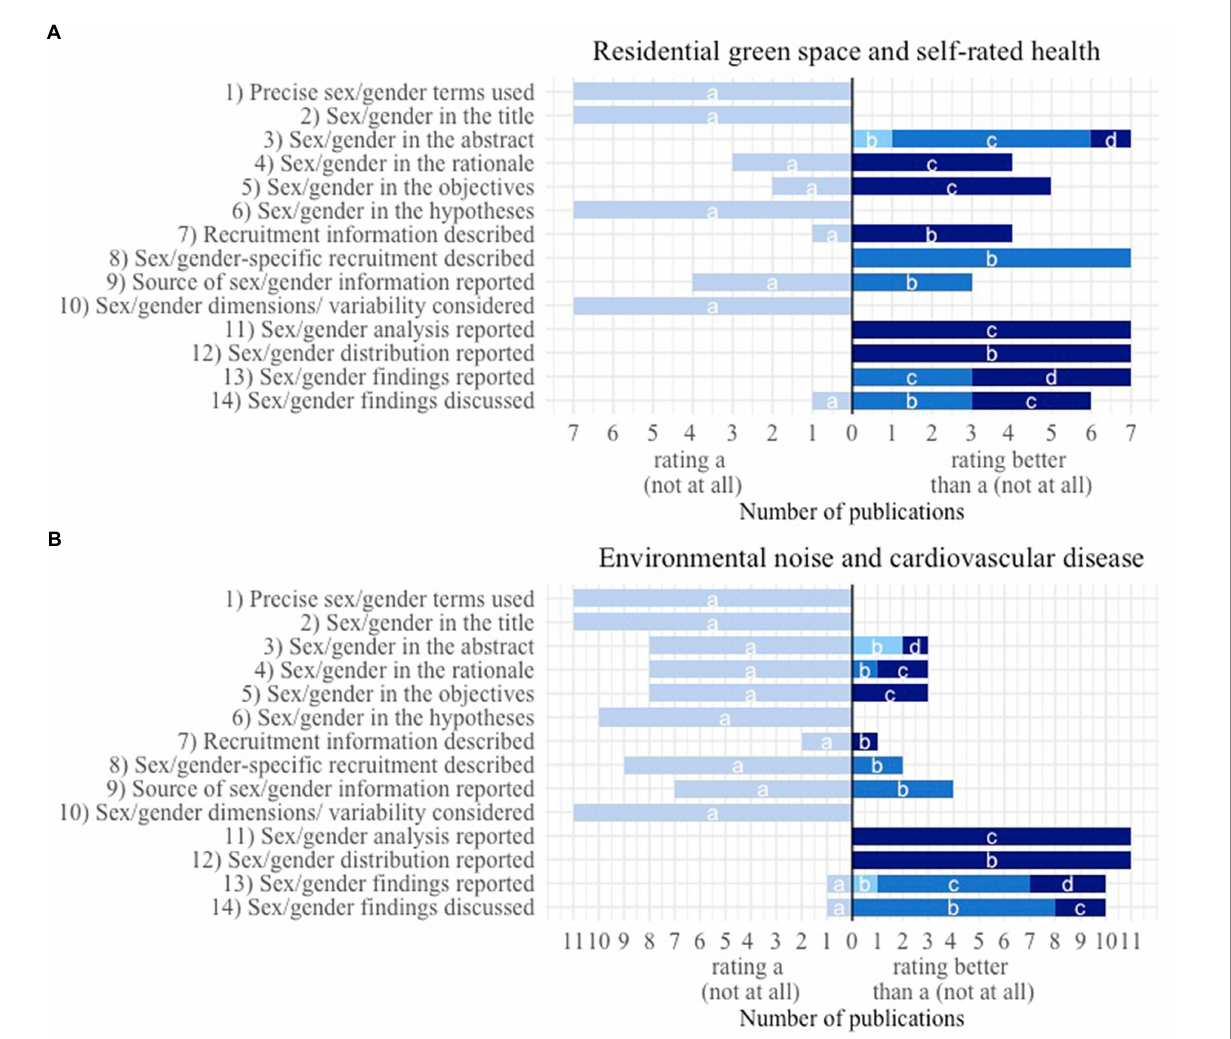
FIGURE 2 Number of publications with a specific rating of the 14 criteria to assess sex/gender consideration. Fulfillment of the evaluation criterion: a – not at all; b, c or d – to a certain extent depending on the specific criterion (for a detailed explanation see results section). (A) Publications identified by the systematic review of Bolte et al. (18) assessing sex/gender in the association between residential green space and self-rated health ( n = 7). (B) Publications identified by the systematic review of Rompel et al. (15) assessing sex/gender in the association between environmental noise and cardiovascular disease ( n =